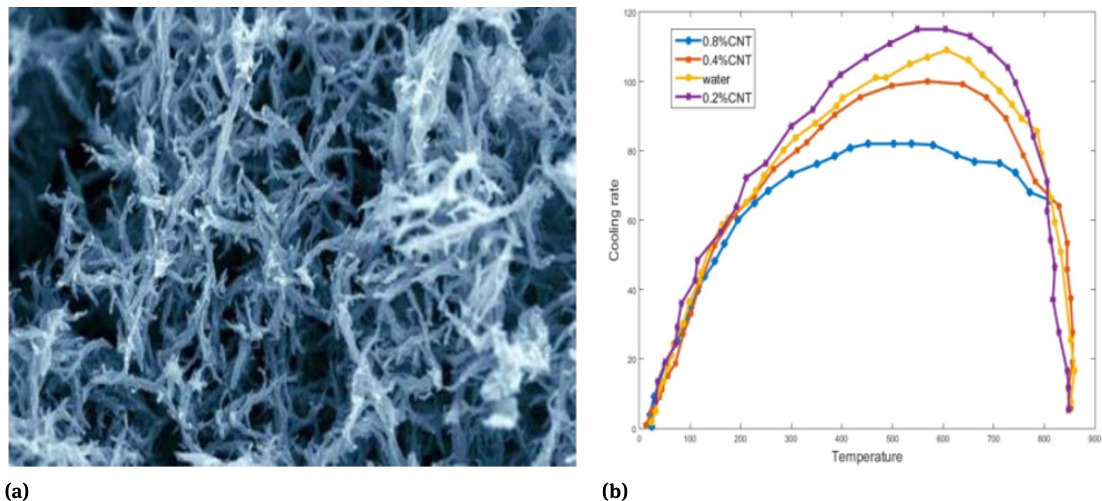
Figure 5: SEM image of the water-based CNTs nano-fluid (a); cooling curve of the temperature probe material quenched by the nano-fluid (25 ∘ C initial temperature) with different CNTs concentrations, considering the water as reference liquid